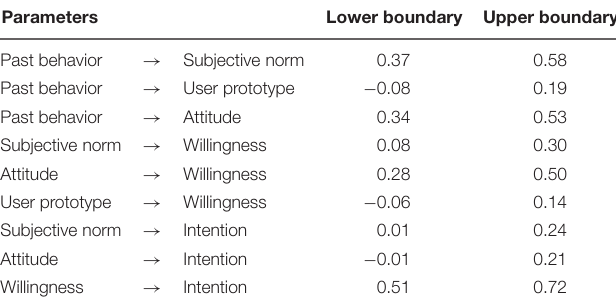
TABLE 2 | Bootstrapped 95% CI s for regression weight ( β stand .